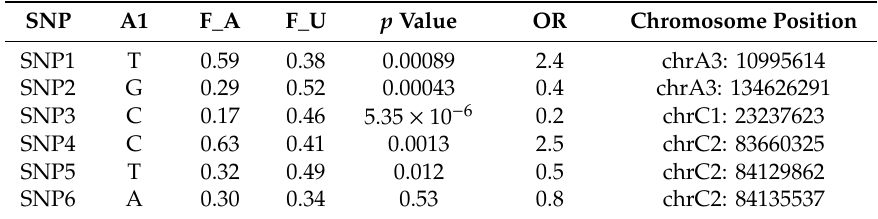
Table 2. Testing candidate SNPs in a validation cohort. DNA samples from a further 37 diabetic ABB cats, 47 normoglycaemic Australian-bred Burmese cats, and 84 Burmese cats from the low-prevalence US population were genotyped at the SNPs implicated by the GWAS. Results were analysed using Plink. A1 indicates the minor allele (i.e., least frequently observed based on the whole sample); F_A and F_U indicate the frequency of the minor allele in the a ff ected and una ff ected cats, respectively. The p value is shown calculated using Fisher’s Exact test and Bonferroni correction. No odds ratio could be calculated for SNP2 because the associated allele was not found in the non-diabetic cats.